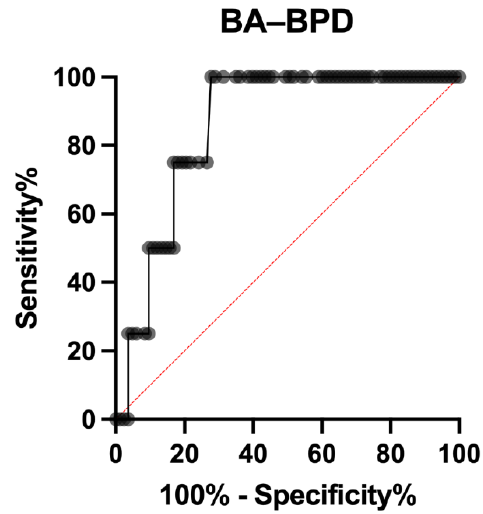
Figure 5. ROC curve of BA–BPD for shoulder dystocia prediction. Similarly, BA/HC ratio showed an AUC of 0.867 (95% CI 0.773 to 0.962; p = 0.013), showing that a threshold of at least 0.435 was the best cut-off, with a 4.500 positive likelihood ratio, a sensitivity of 75.00% (95%, CI 30.06% to 98.72%) and a specificity of 83.33% (95 CI 73.95% to 89.80%) (Figure 6).